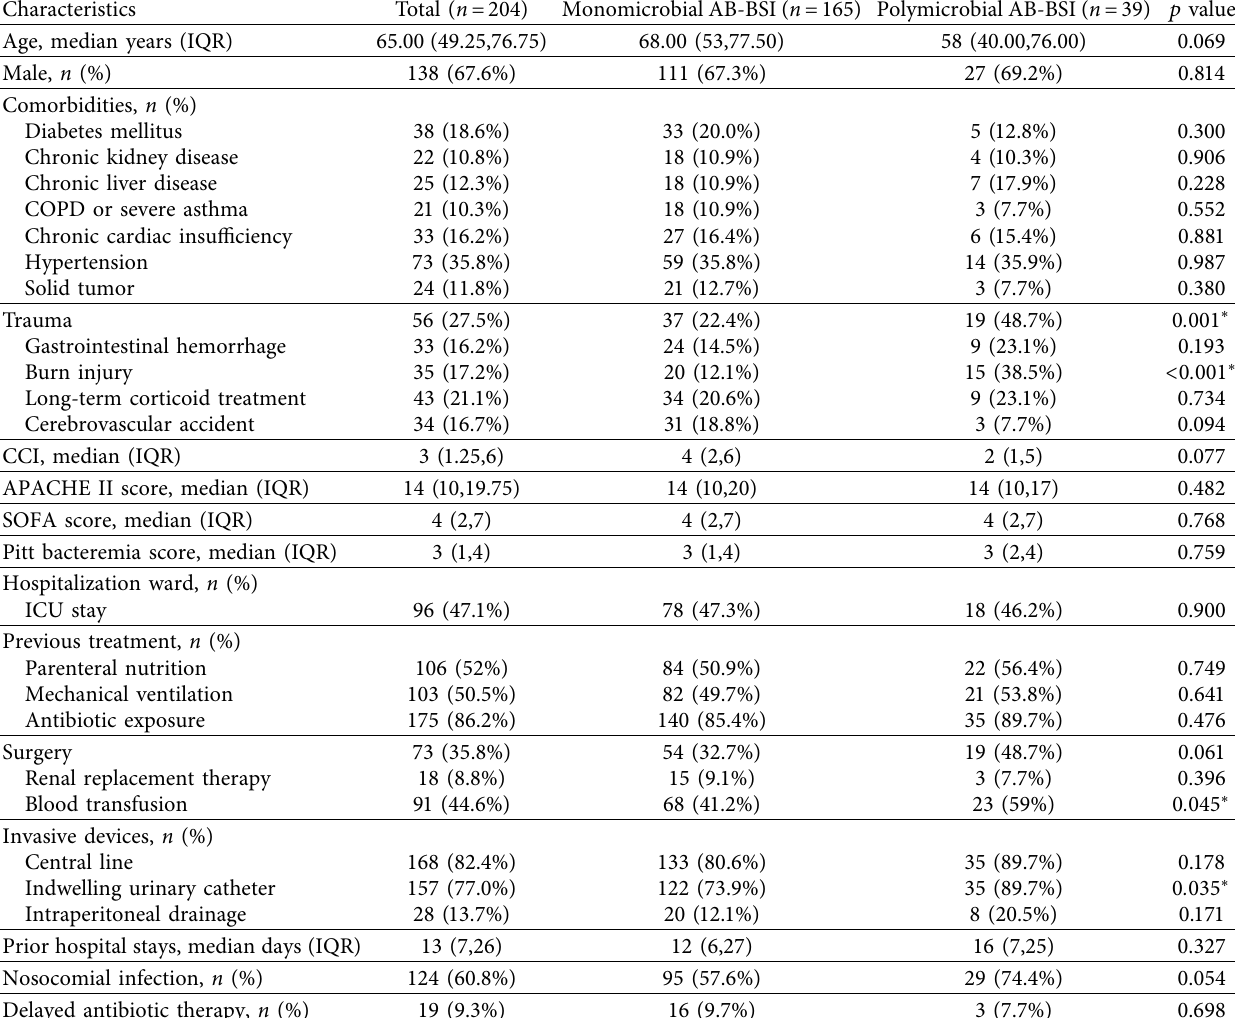
Table 1: Baseline characteristics of patients with polymicrobial and monomicrobial AB-BSI.